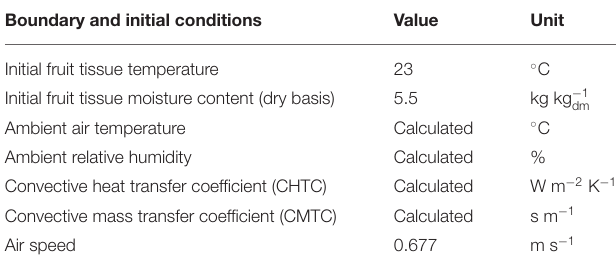
TABLE 3 | Boundary and initial conditions.